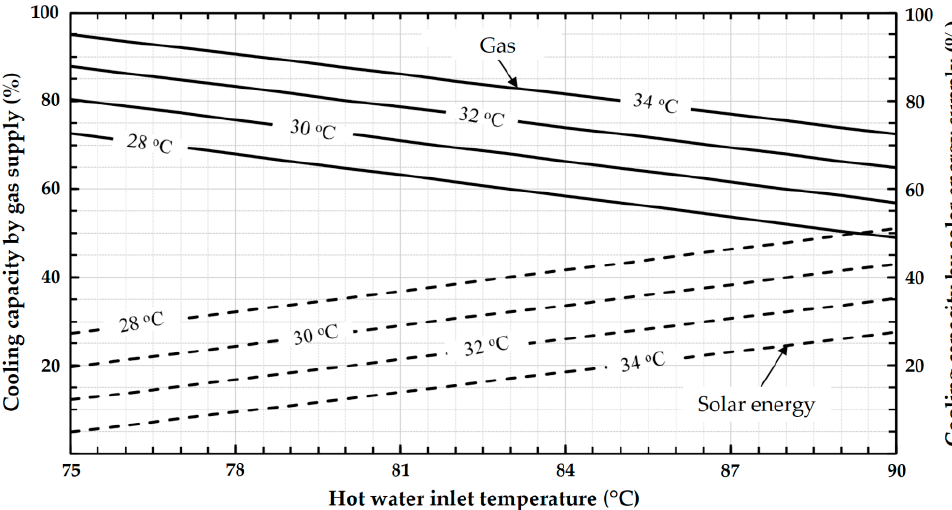
Figure 11. Effect of driving hot water inlet temperature for the contribution of solar energy and